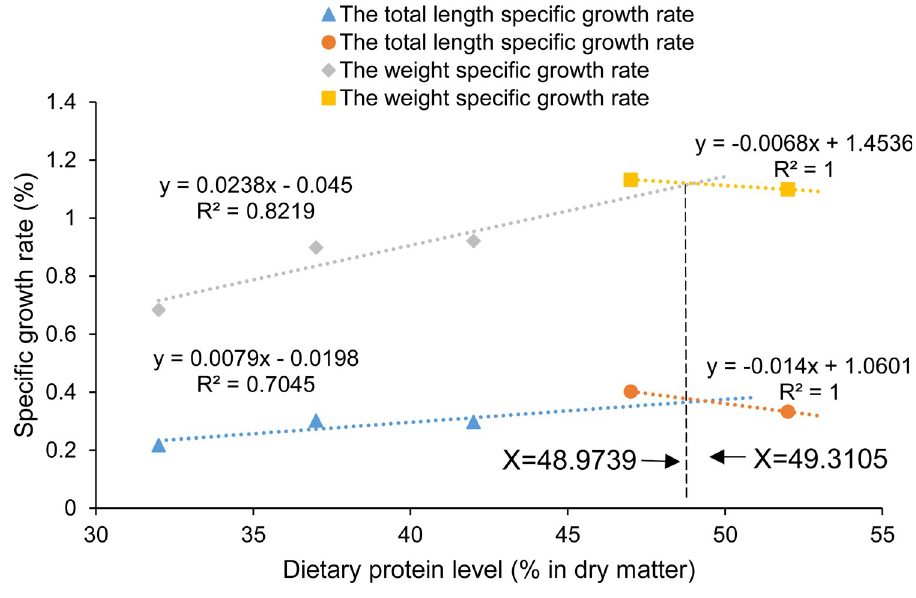
Fig 1. Relationship between varying dietary protein levels and specific growth rate of Culter mongolicus